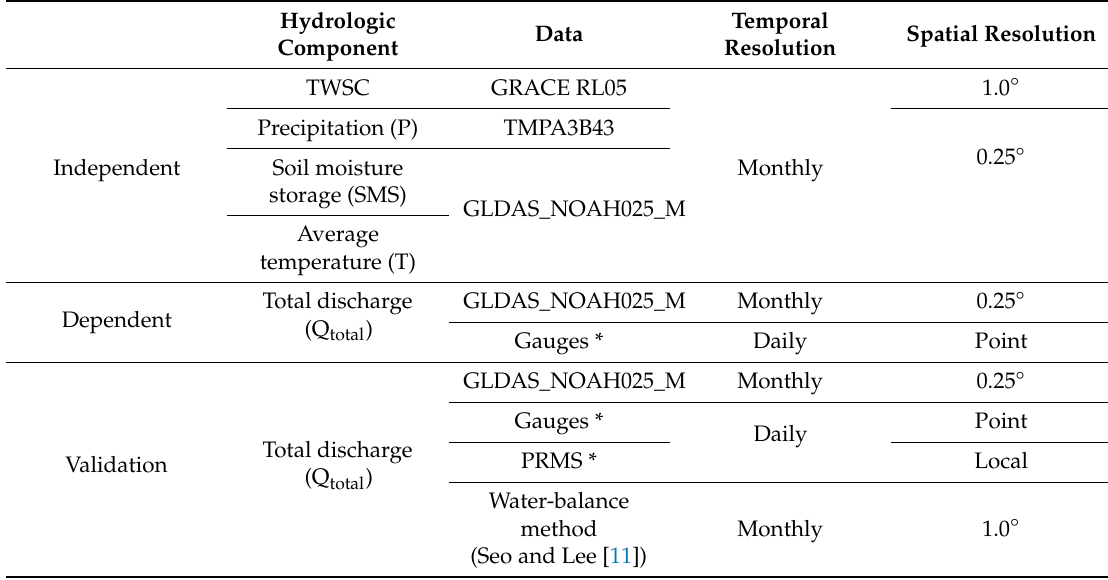
Table 2. Characteristics of data used in this